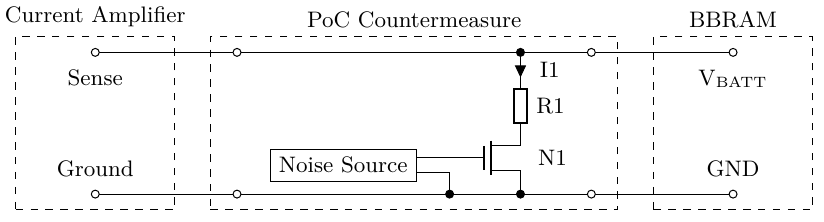
Figure 17: Test setup for the proof-of-concept